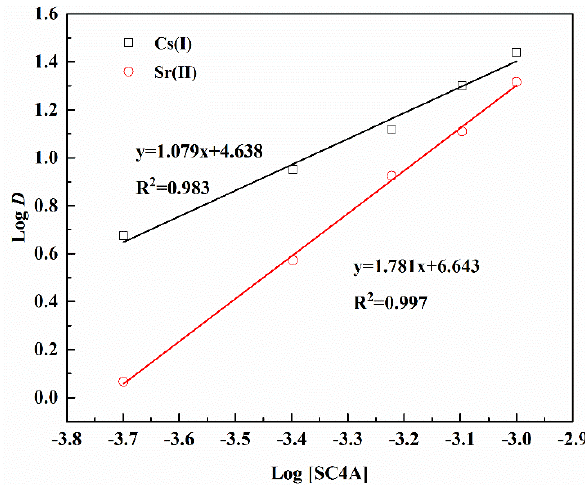
Figure 4. Relationship between log D and log [SC4A]. Conditions: T = 298 K, pH = 6, [Metal] (a) = 1 × 10 − 4 M, contact time = 60 min, shaking speed: 150 rpm.